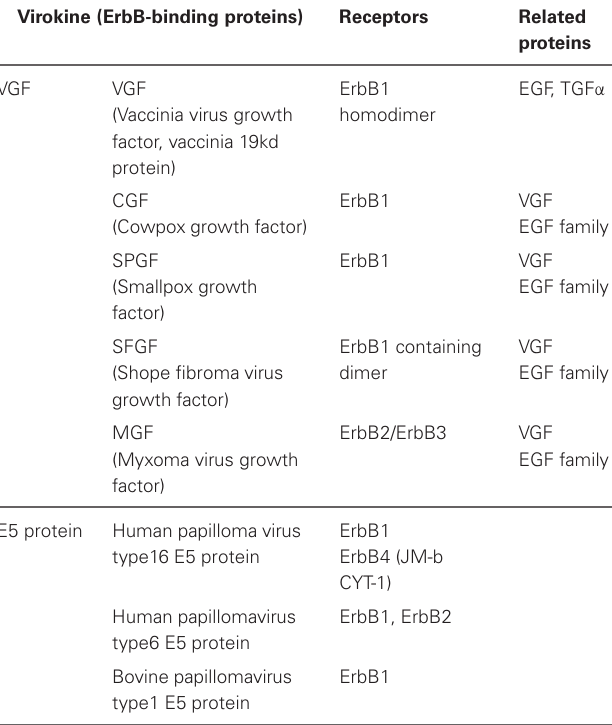
Table 3 | Virokines that bind to ErbB